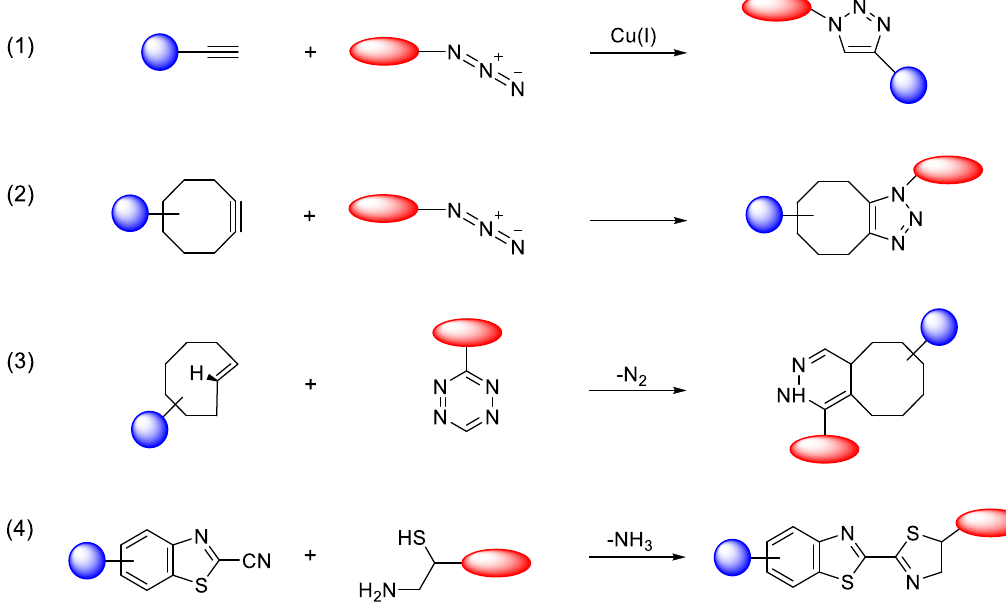
Figure 1. Selected bioorthogonal conjugation reactions. ( 1 ) Copper-catalyzed azide-alkyne cycloaddition reaction (CuAAC); ( 2 ) strain-promoted azide-alkyne cycloaddition reaction (SPAAC); ( 3 ) tetrazine and trans-alkene substrates for inverse electron-demand-Diels–Alder reaction (IEDDA); ( 4 ) condensation reaction between 2-cyanobenzothiazole (CBT) and 1,2-aminothiol ( N -terminal